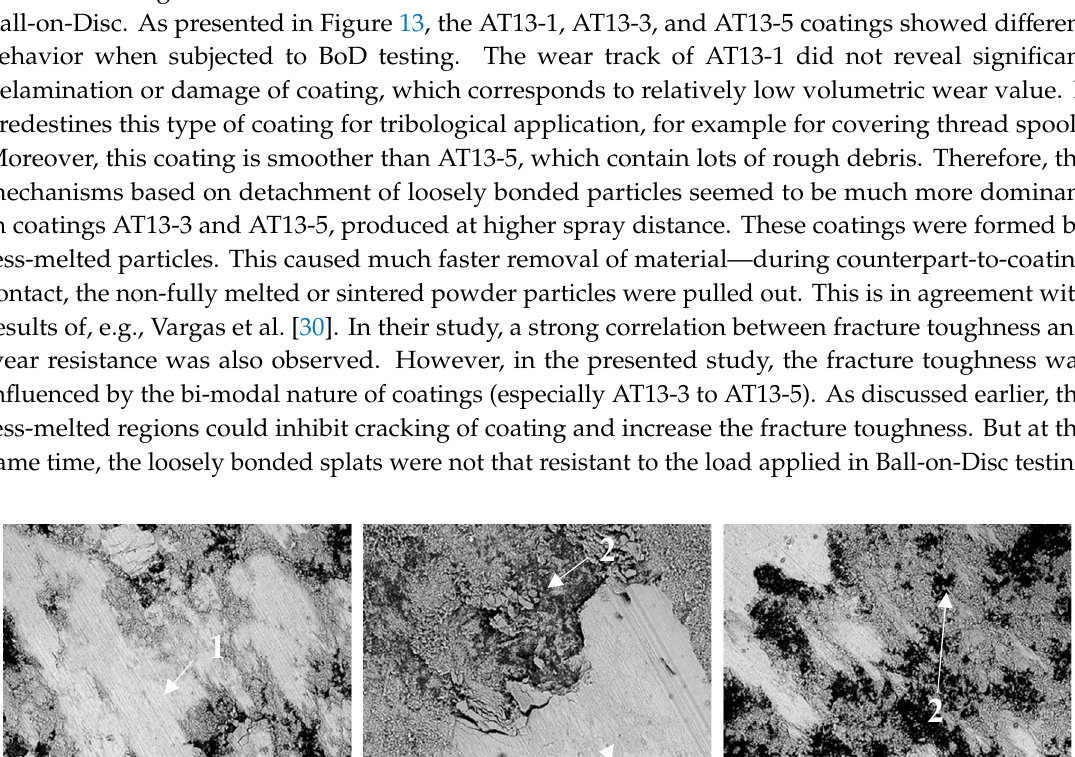
Figure 12. The results of Ball-on-Disc test for AT13 coatings.